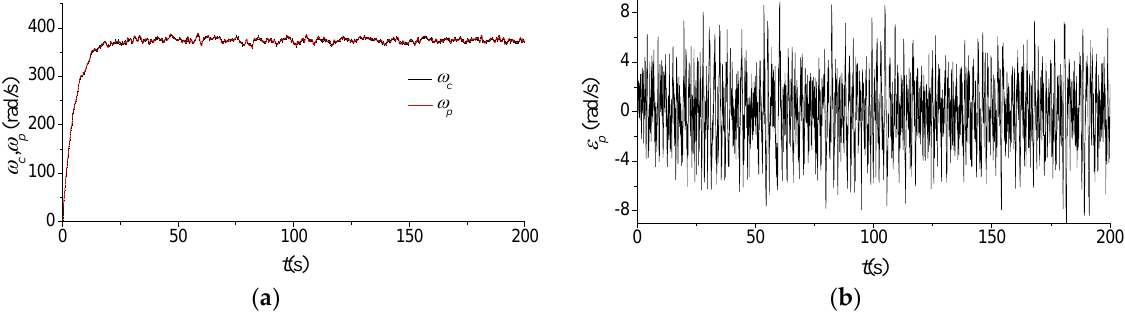
Figure 7. Experimental results of the optimized proportional-integral-differential (PID) controller. ( a ) ω c and ω p ; ( b ) ε p .